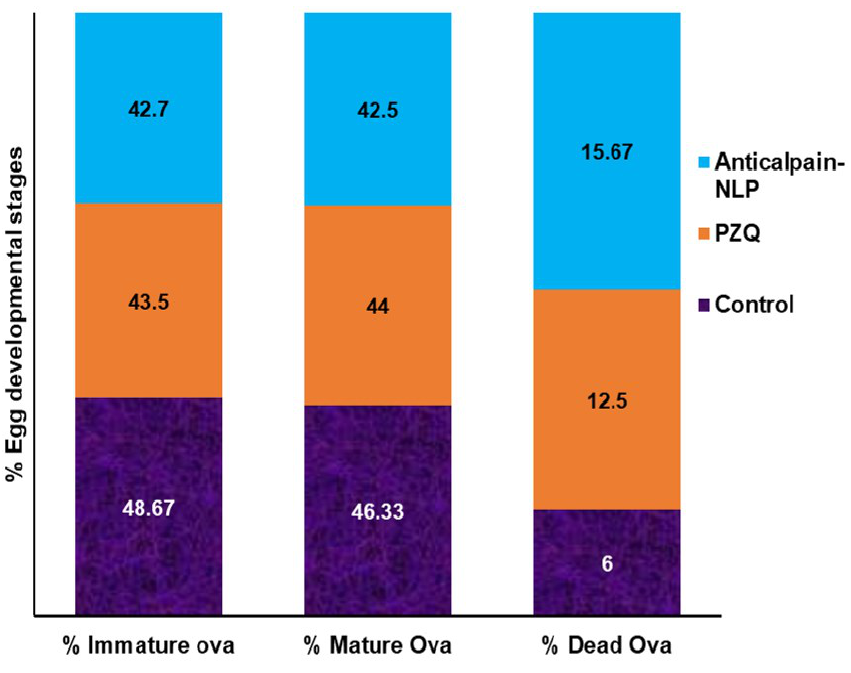
Figure 14. Effect of PZQ and anti-calpain-NLP (single dose 250 mg/kg four weeks post infection) on % Egg developmental stages in S. mansoni -infected mice sacrificed six weeks post infection. Table 4. Effect of PZQ and anti-calpain-NLP (single dose 250 mg/kg four weeks post infection) on number of ova/gm tissues in S. mansoni -infected mice sacrificed six weeks post infection.